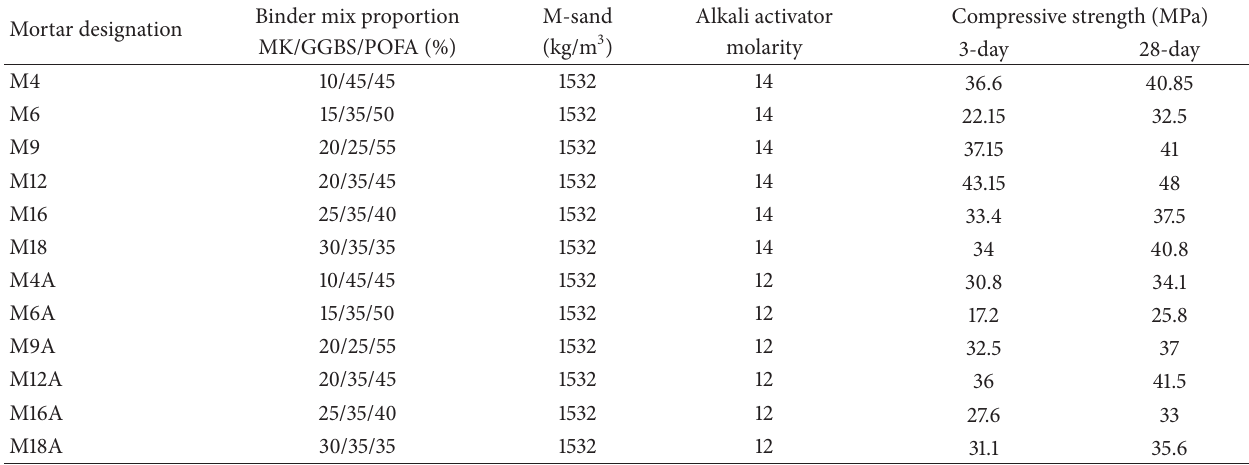
Table 7: Comparison of the compressive strength between different molarities.